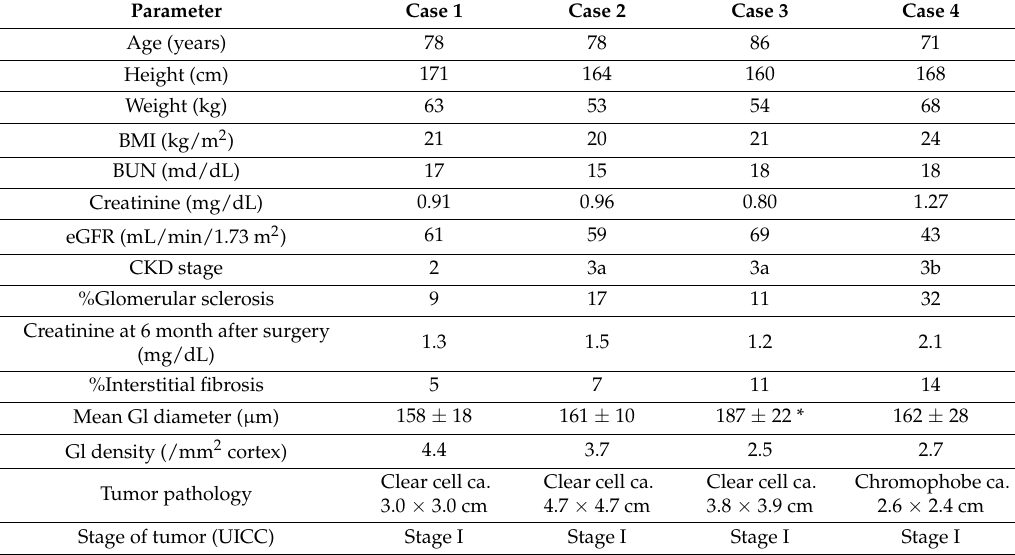
Table 1. Clinical characteristics of four